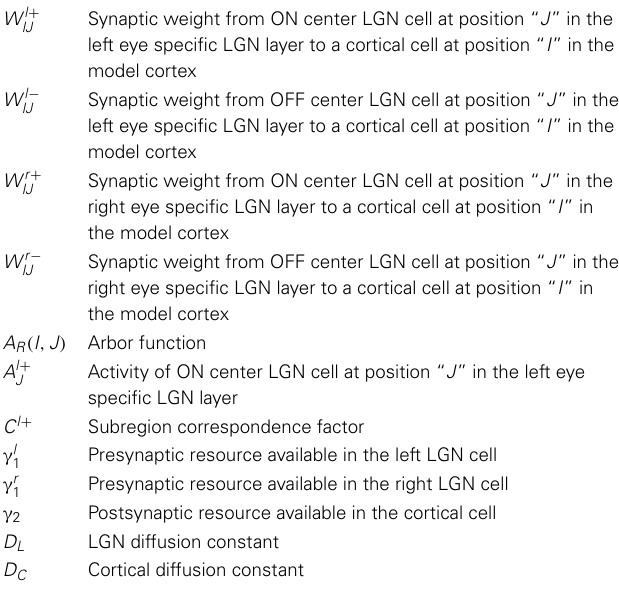
Table 1 | List of variables and model